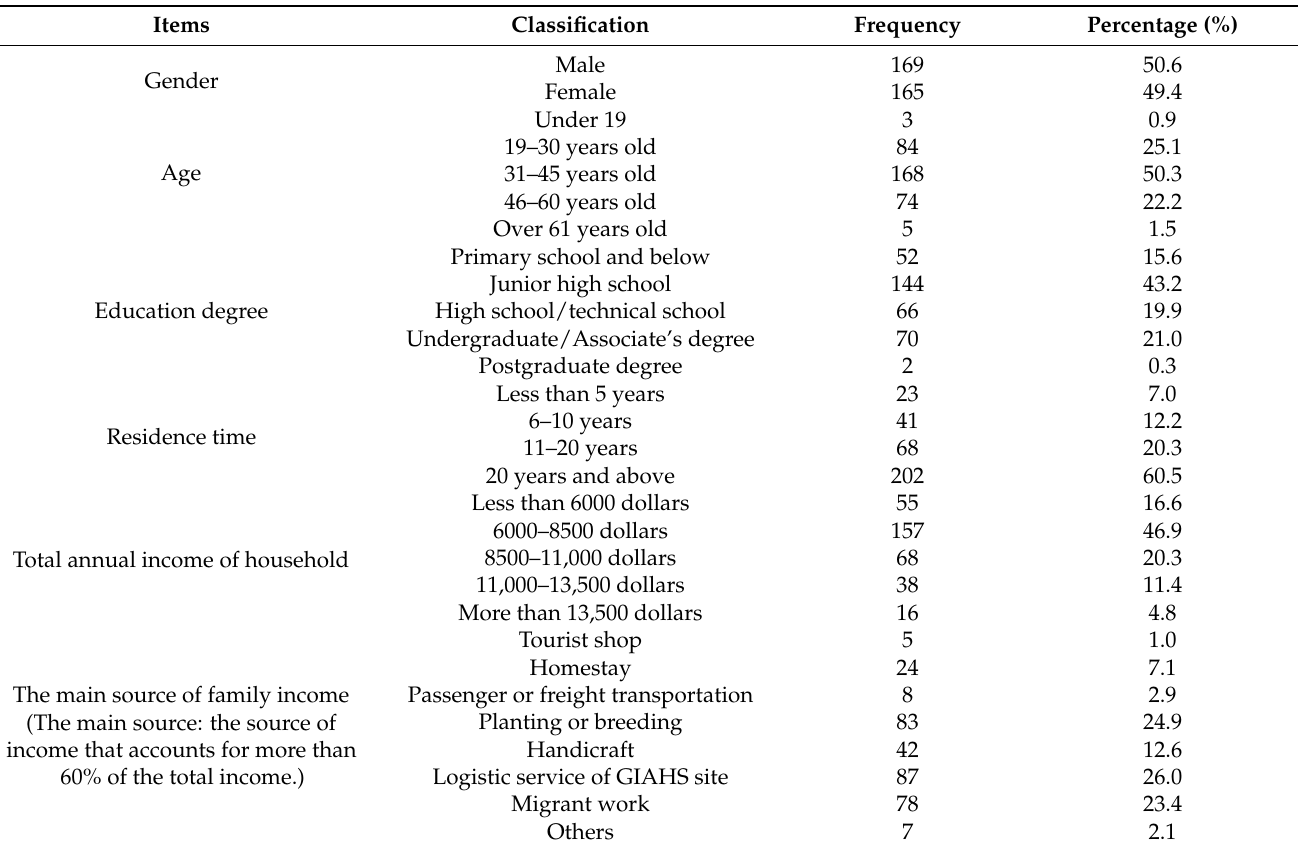
Table 2. The demographic characteristics of the research